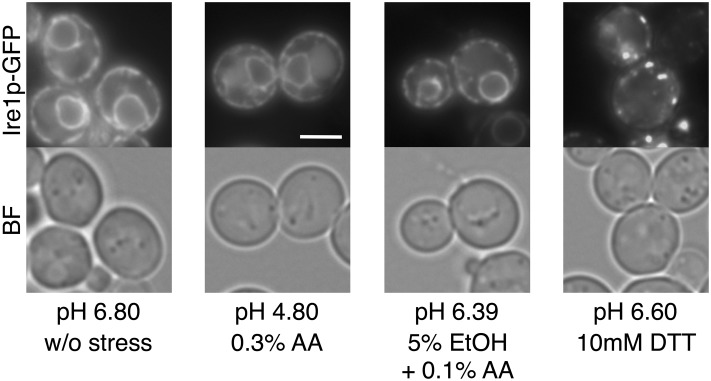
Effects of extracellular dissociated acetic acid on the UPR. Exponentially growing cells were exposed to the indicated conditions for 60 min using the SD-PPB medium whose pH was adjusted to 6.80 by potassium phosphate buffer. Final pH values after addition of acetic acid, ethanol, and DTT into the SD-PPB medium are indicated. Ire1p-GFP was immediately observed after the treatment. Representative pictures are shown. BF, bright field. The white bar indicates 3 μm.